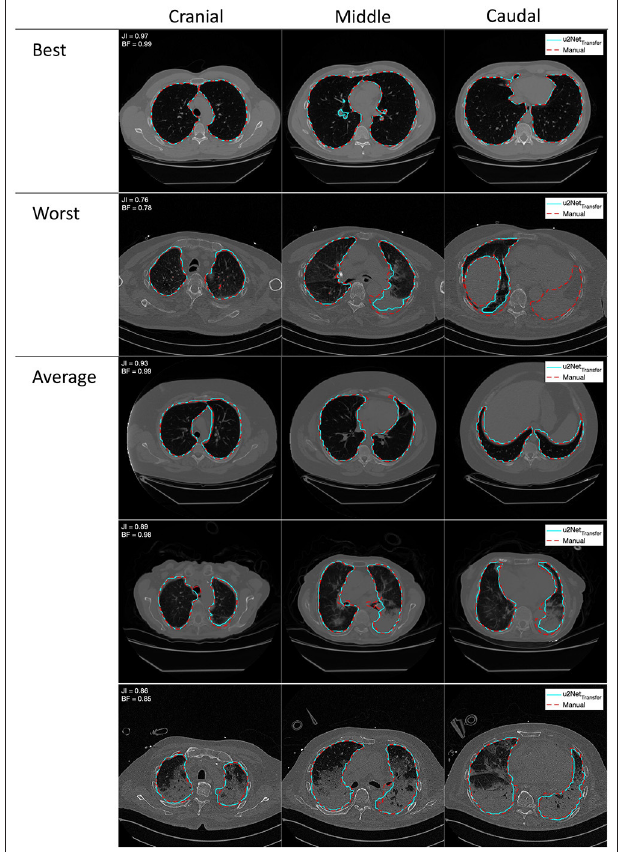
FIGURE 4 | Outlines of best, worst, and average segmentations generated from the double resolution architecture u 2 Net Transfer (cyan) compared to the manual segmentation (red), overlayed on the relative coronal CT slice. Images in each row come from a single scan progressing cranio-caudally from left to